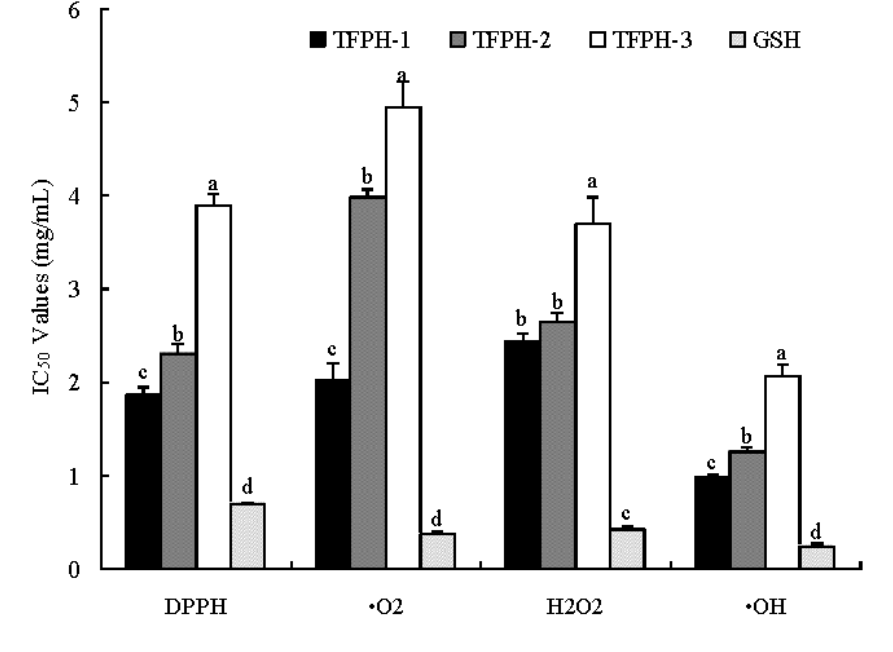
Figure 1. The IC values of TFPH fractions on scavenging radicals activities. GSH: 50 glutathione. Bars indicate the standard deviation from triplicate determinations. Different letters indicate significant differences ( p <